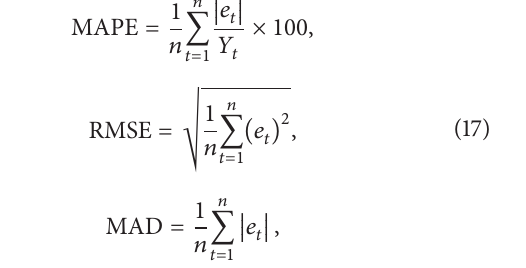
Table 6: Performance comparison of typical single-stage and the proposed hybrid models. MAPE RMSE MAD Single-stage